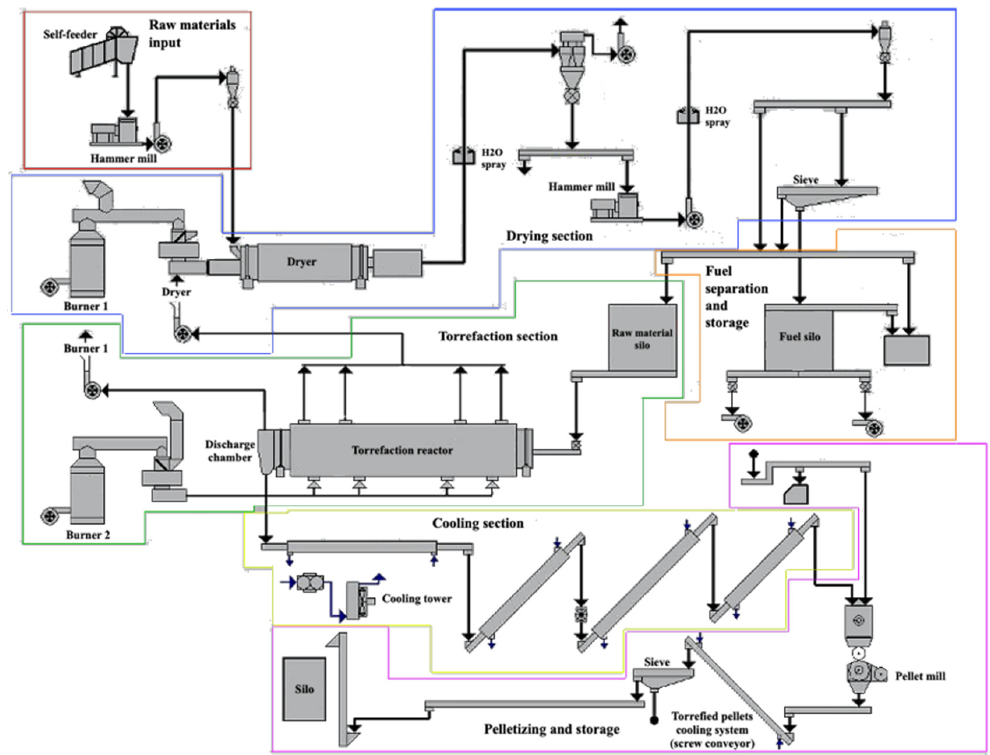
Figure 5. Different sections that form the production line of YGE—Yser Green Energy SA. Figure 5. Di ff erent sections that form the production line of YGE—Yser Green Energy SA.